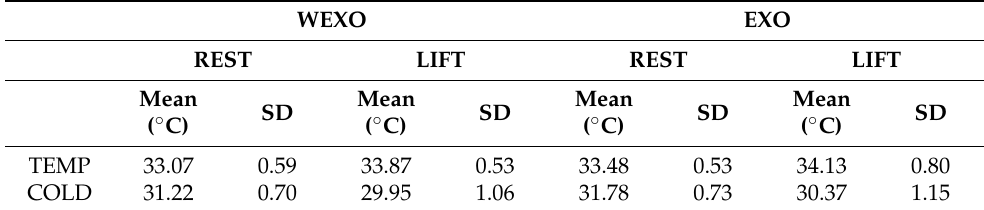
Table A2. Mean (SD) values of mean skin temperature during the experimental sessions.